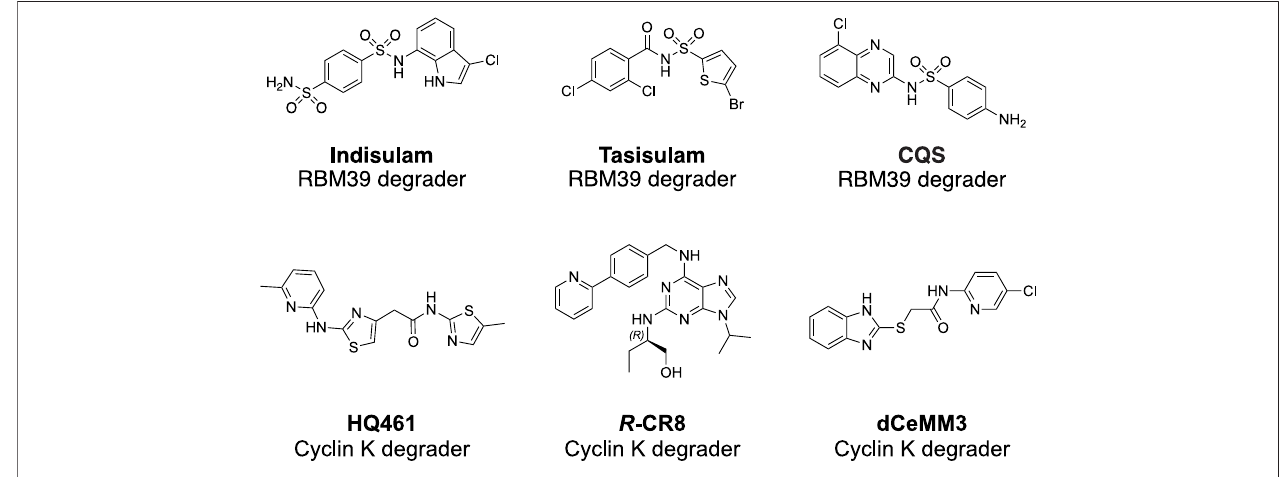
FIGURE 3 | Structures of RBM39 degrading sulfonamides and CDK12 dependent Cyclin K degraders.